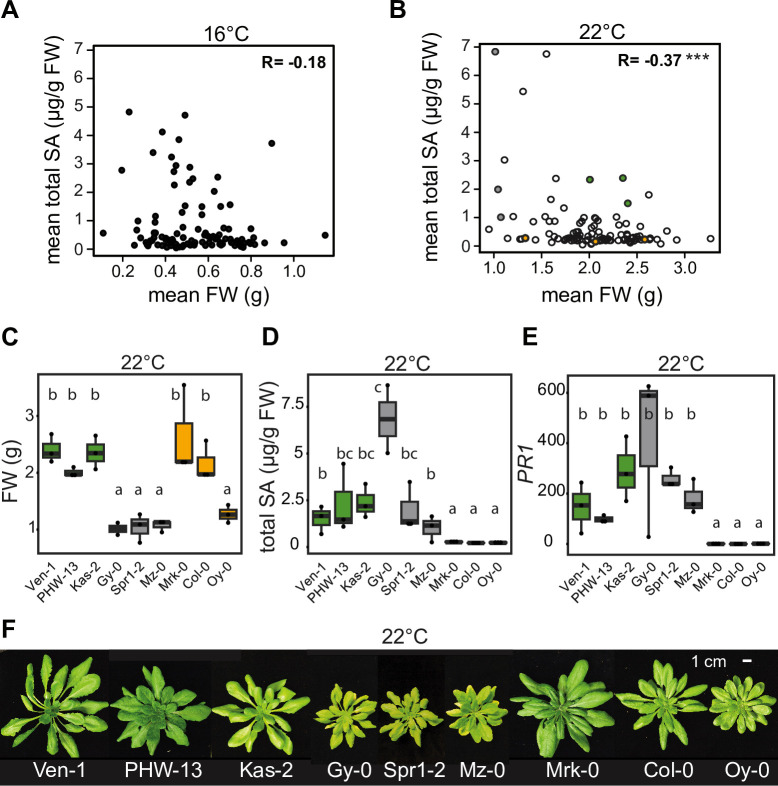
Natural variation in growth—defense tradeoffs in A. thaliana.A) Scatterplot of mean above-ground fresh weight (FW) according to mean leaf total SA contents of 105 A. thaliana accessions grown for 5 weeks at 16°C. R = Pearson’s correlation index. Data are from four biological replicates (t = -1.9184, df = 103, p-value = 0.05783). B) Scatterplot of mean above-ground FW according to mean leaf total SA contents of 105 A. thaliana accessions grown for 5 weeks at 22°C. R = Pearson’s correlation index. Data are from three biological replicates (t = -4.0581, df = 103, p-value = 9.651e-05). Green dots represent accessions with high biomass and high SA accumulation, grey dots represent accessions with low biomass and high SA accumulation and orange dots represent accessions with varied biomass and low SA accumulation phenotyped in Fig 2C–2F. C) Above-ground FW in 5-week-old plants of nine A. thaliana accessions grown at 22°C (n = 3 biological replicates). Letters indicate significant differences after FDR multiple testing correction in one-way ANOVA. D) Leaf total SA contents in 5-week-old plants of nine A. thaliana accessions grown at 22°C (n = 3 biological replicates). Letters indicate significant differences after FDR multiple testing correction in one-way ANOVA. Data was log(10) transformed for statistical analysis. E) Expression of PR1 relative to SAND reference gene in 5-week-old plants of 9 A. thaliana accessions grown at 22°C (n = 3 biological replicates). Letters indicate significant differences after FDR multiple testing correction in one-way ANOVA. Data was log(10) transformed for statistical analysis. F) Visual growth phenotypes of 5-week old A. thaliana accessions examined in c) to e).